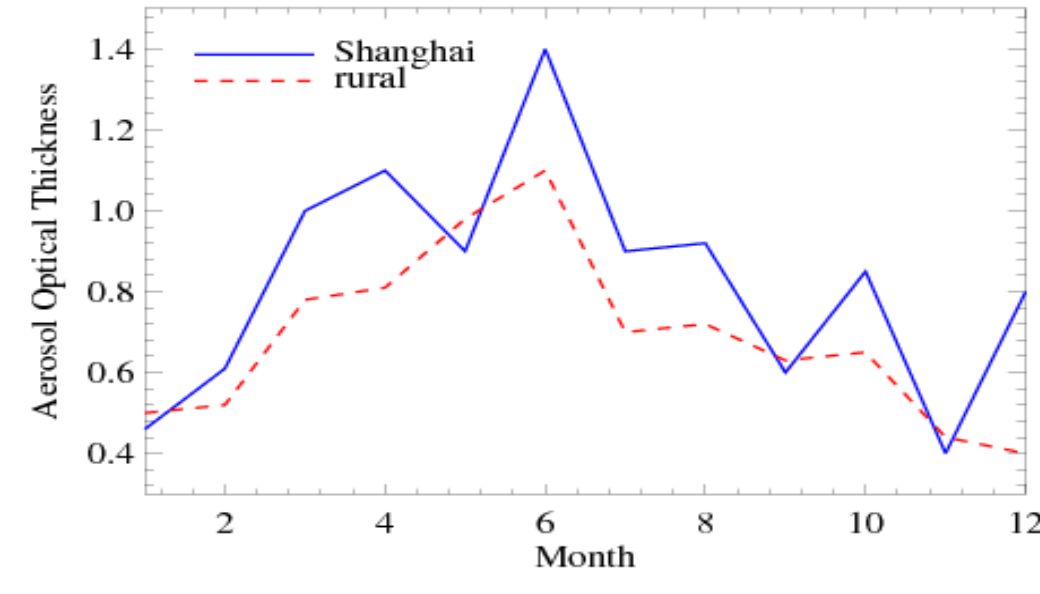
Figure 9. Daily MODIS observed aerosol optical thickness (AOT) for July 2007, where red solid line represents Shanghai and green solid line represents the rural